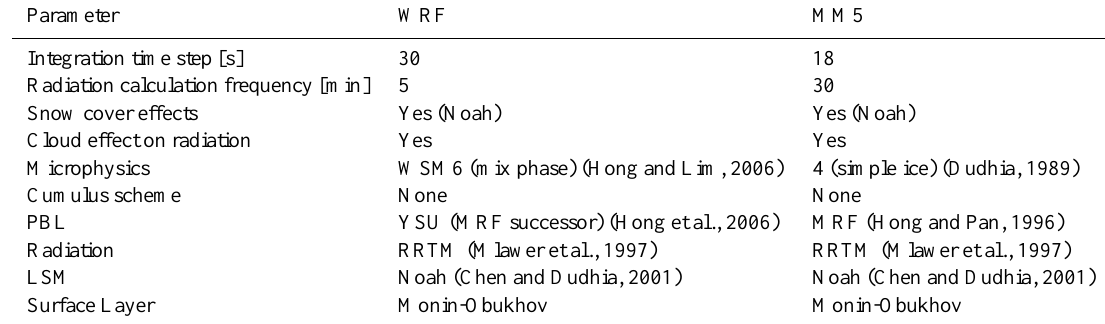
Table 2. Overview of the WRF and MM5 parameterisations, which are used to create the meteorological input for CHIMERE. Parameter WRF MM5 Integration time step [s] 30 18 Radiation calculation frequency [min] 5 30 Snow cover effects Yes (Noah) Yes (Noah) Cloud effect on radiation Yes Yes Microphysics WSM6 (mix phase) (Hong and Lim, 2006) 4 (simple ice) (Dudhia, 1989) Cumulus scheme None None PBL YSU (MRF successor) (Hong et al., 2006) Radiation